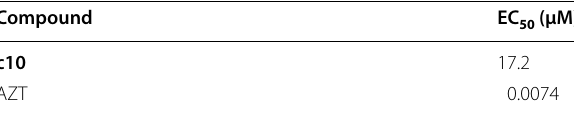
Table 32 Antiviral activity results of compound c10 Compound